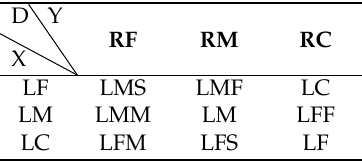
Table 2. Fuzzy rules for the indoor patrol controller of left wheel speed.